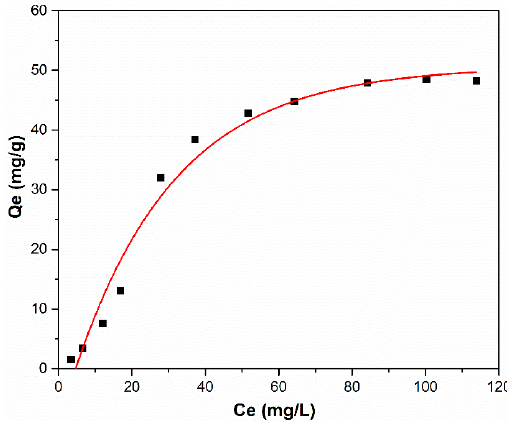
Figure 7. Equilibrium adsorption isotherm for zinc ions onto HAp at room temperature. The Langmuir and Freundlich linearized fits for the adsorption of zinc ions on HAp are shown in Figure 8. The constants calculated from the linearized plots are reported in Table 2.